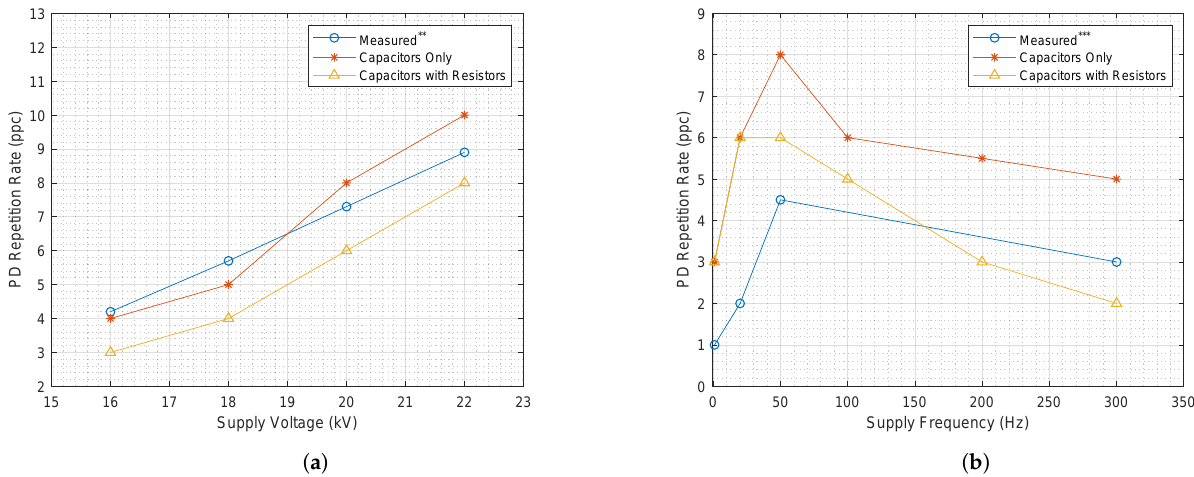
Figure 4. Simulated results using capacitors only ABC model and capacitors with resistors model plotted together with measured data obtained from the literature ( a ) supply voltage amplitude ( ∗∗ : measured values as reported by Illias et al. [26]; NB: The last point at 22 kV has been extrapolated); ( b ) supply voltage frequency ( ∗∗∗ : measured values as reported by Cavallini et al.